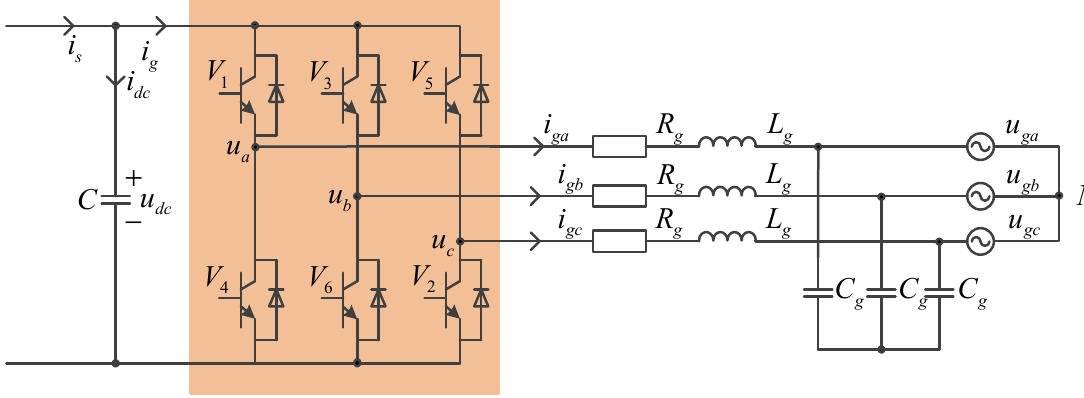
Figure 2. Grid-side pulse width modulation (PWM) converter circuit topology.